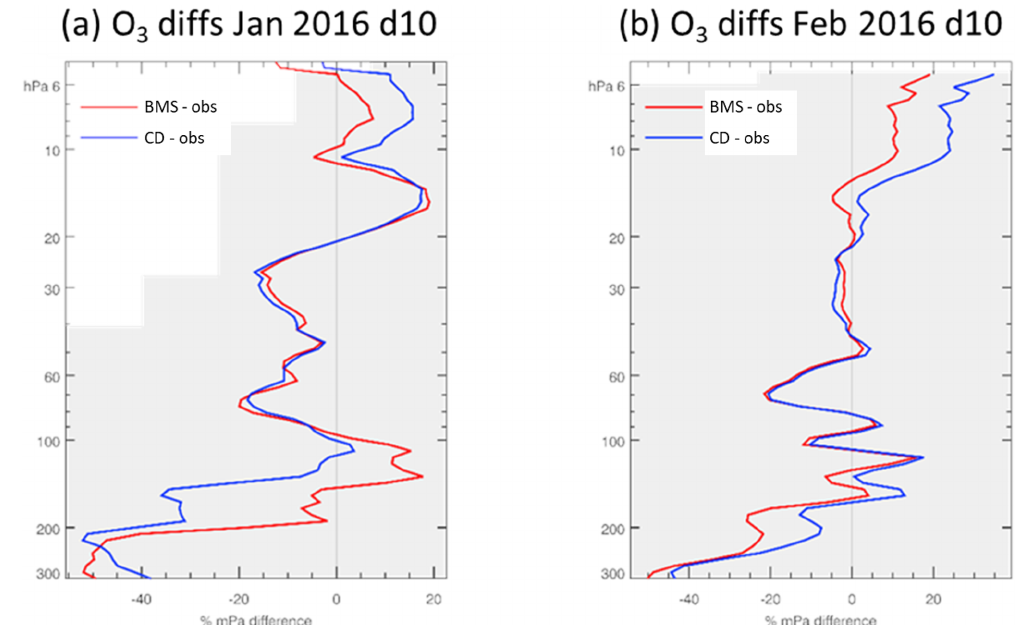
Figure 6. Averaged vertical profiles of ozone percentage differences for the Irish station of Valentia (52 ◦ N, 10 ◦ W) in (a) January and (b) February 2016 for the model run using the new ozone scheme interactive with radiation (red) and the default ozone configuration (blue). Profiles used, both for model runs and observations, correspond to day 10 in the forecast runs. Shaded areas indicate the density of observation profiles for the corresponding altitude range for the considered period.